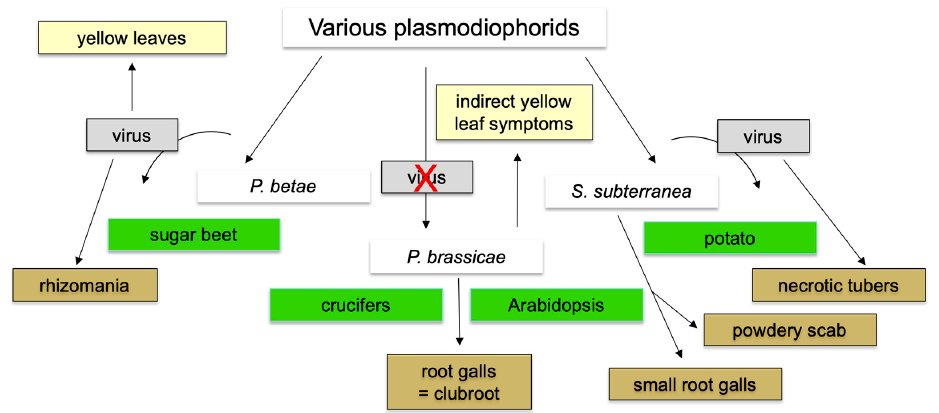
Figure 5. Comparing three plant pathogenic plasmodiophorids, P. brassicae , P. betae , and S. subterranea for their disease symptoms or virus transmitter capability. Only those with currently available genome information are shown. The red cross indicates no virus transmission.